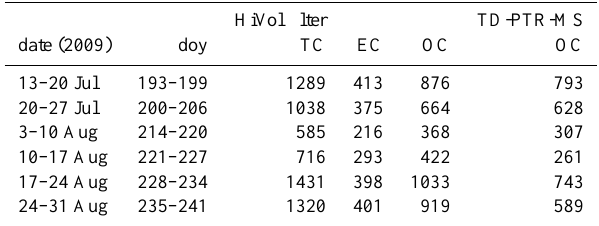
Table 2. Results of an OC/EC analysis of filter samples and OC values derived from TD-PTR-MS. Units are ngm − 3